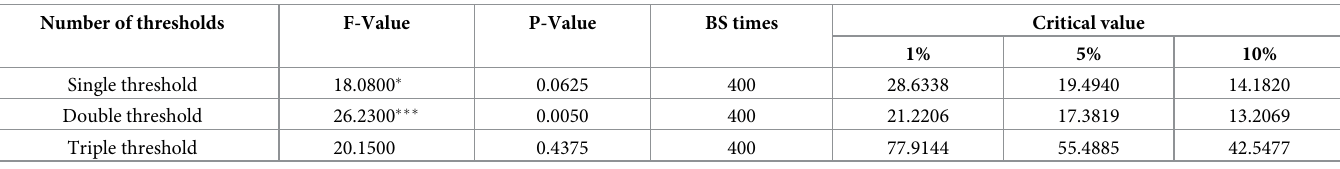
Table 3. Sample inspection results of threshold